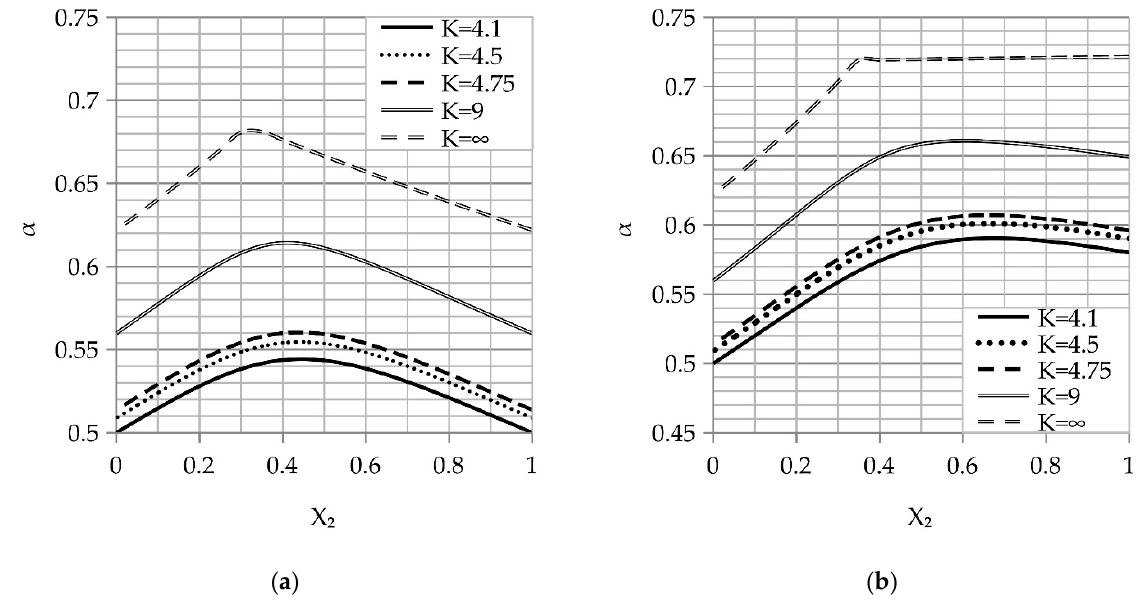
Figure 2. The plots of the actual density of the double fracture packing ( α ) as a function of the second fraction content (X 2 ) in different packing processes ( K ) at the same granular mix ( ψ = 0.5) for: ( a ) the same packing density of the monodisperse fractures and ( b ) the different packing density of the monodisperse fractures.